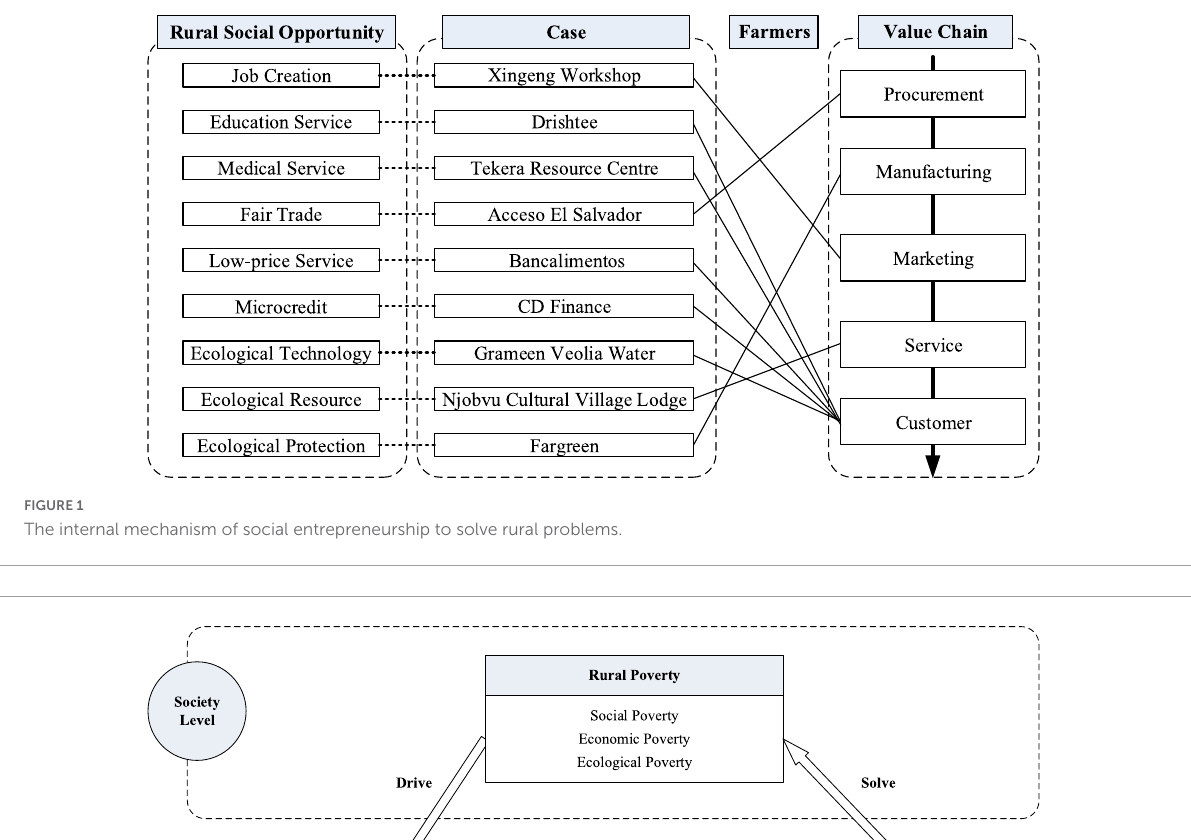
FIGURE2 Sustainable development framework for social